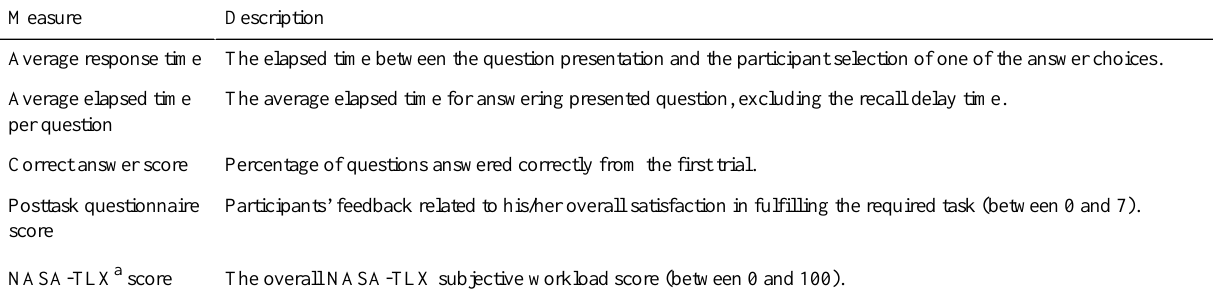
Table 2. Collected measures.